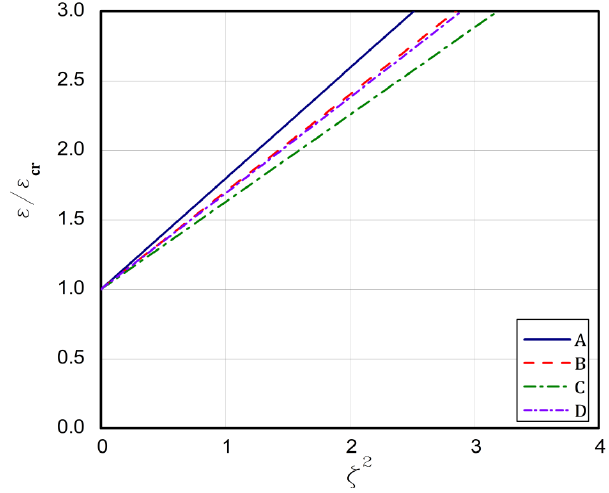
Figure 7. The post-buckling paths cr / in a function of 2 for type 5 of loads of the perfect plates.